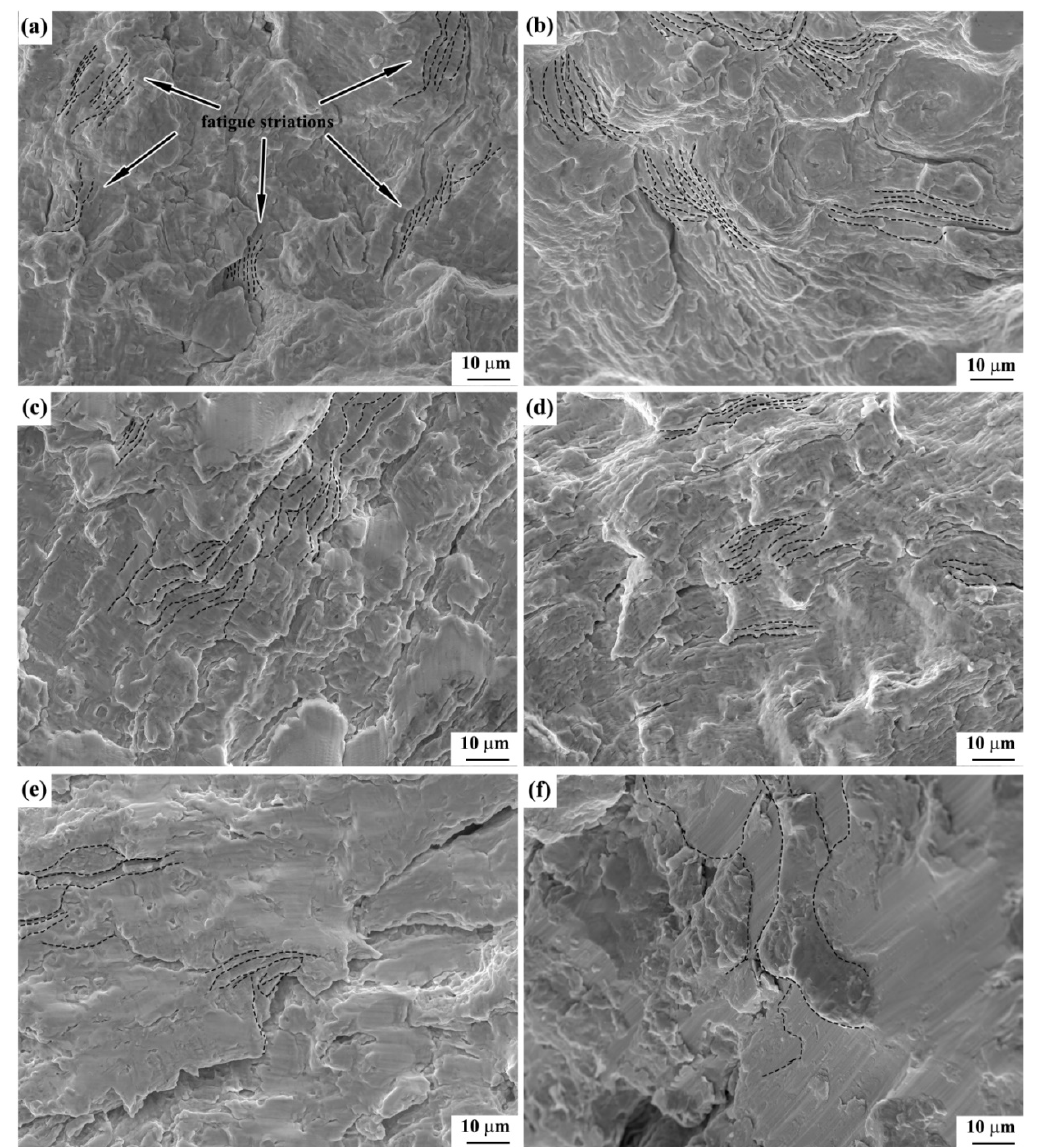
Figure 11. Micro-morphologies of crack growth zone of 22MnSi2CrMoNi steel at ( a ) 0.52%, ( c ) 0.8%, ( e ) 1.0% total strain amplitude; Micro-morphologies of crack growth zone of 00Ni18Co9Mo4Ti steel at ( b ) 0.52%, ( d ) 0.8%, and ( f ) 1.0% total strain amplitude.